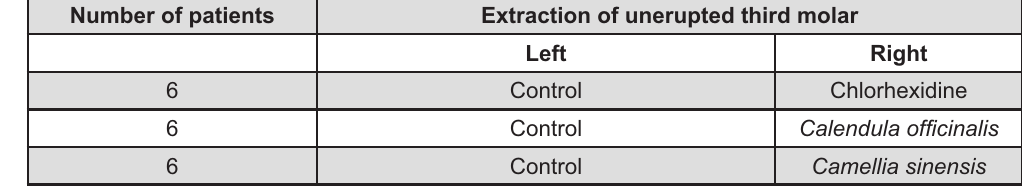
Figure 1- Distribution of the patients according to experimental